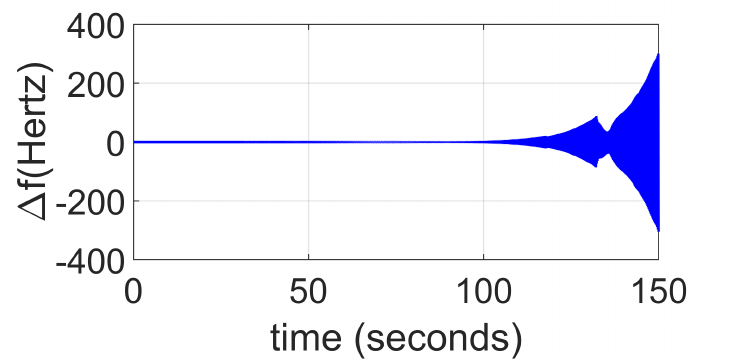
Figure 5. Frequency measurement under scaling attack.